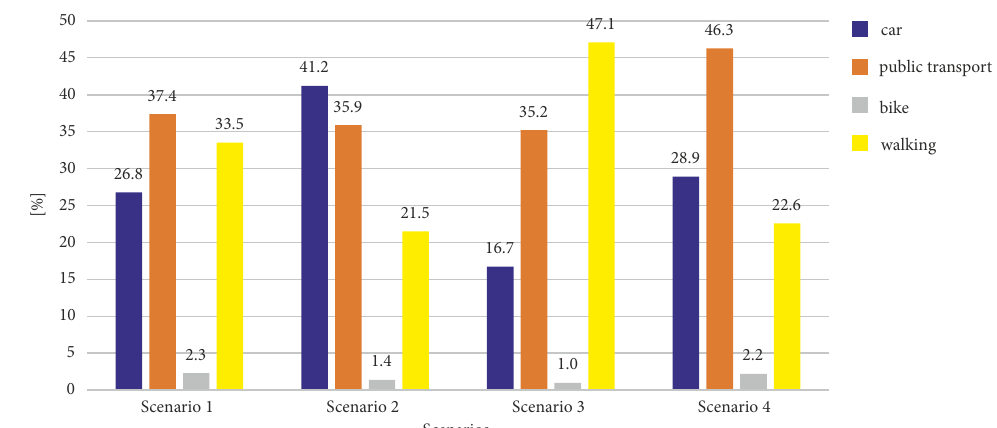
Figure 4. The current modal share of the